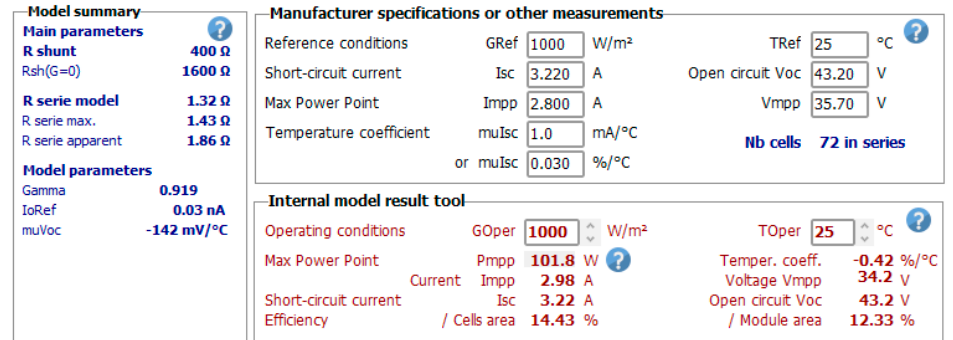
Figure 6. Example of parameters available in the PVsyst software database [43] obtained online. Model ASE-100-GT-FT.